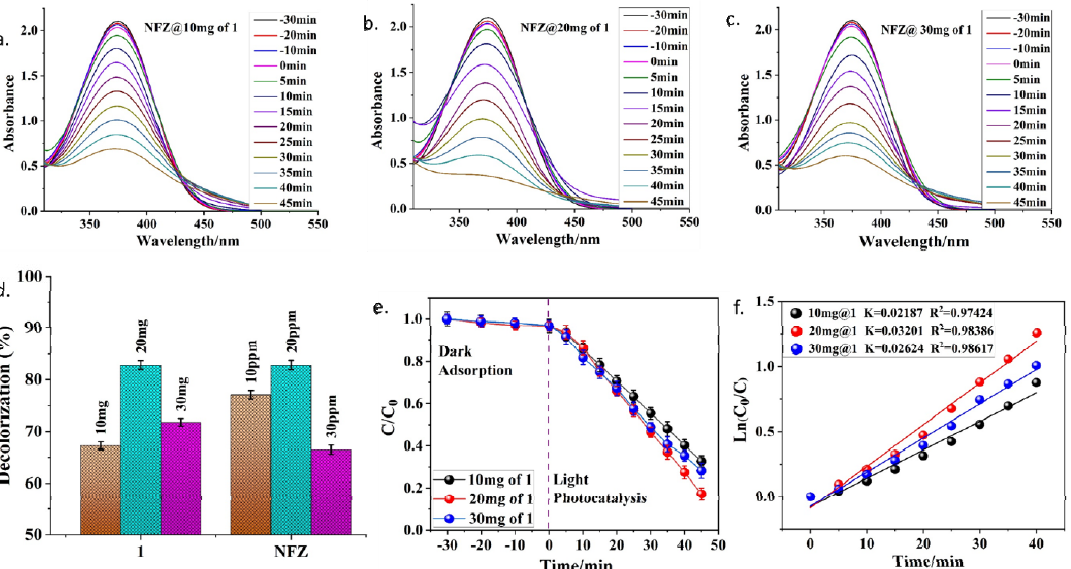
Figure 4. ( a – c ) NFZ degradation performances using 1 at 10 mg, 20 mg, and 30 mg, respectively. ( d ) NFZ antibiotic degradation efficiency of 1 at different dosages. ( e , f ) Kinetic plots for the photocat- alytic degradation of NFZ using different 1